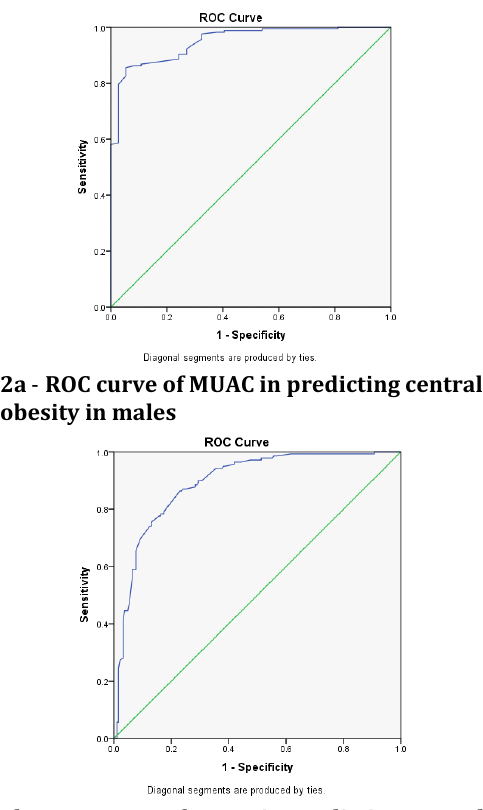
Figure 2: ROC analysis for MUAC and TSFT in detecting central obesity in males and females